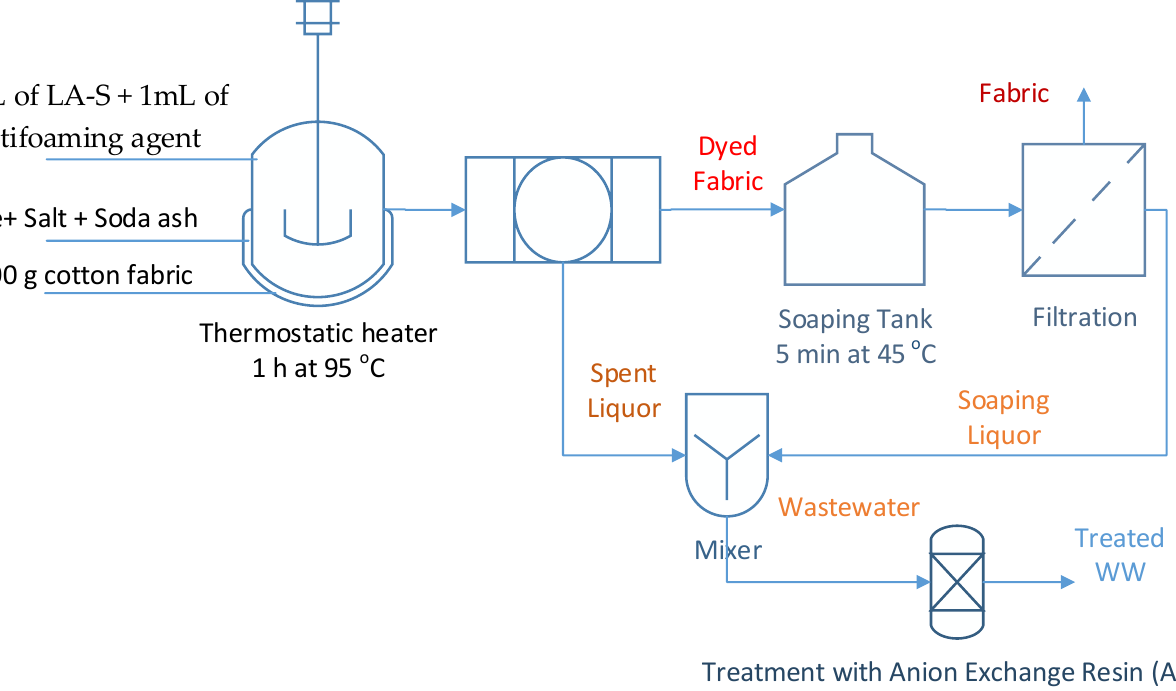
Figure 2. Schematic of dyeing and soaping fabrics for preparing dyed WW. The spent liquors were separated, and the dyed fabrics were soaped with 500 mL water at 45 ◦ C for 5 min. The spent and soaping liquors were separated and compared with other solutions of known concentration using a spectrophotometer, and their average concentrations were